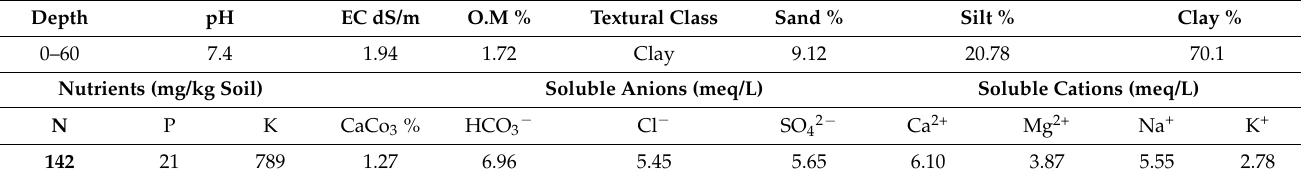
Table 1. Physicochemical analysis for the experimental orchard